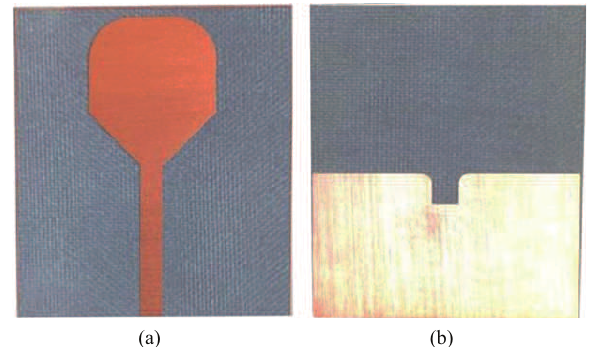
FIGURE 5: Prototype of proposed single element: (a) Top- view. (b Back-view.